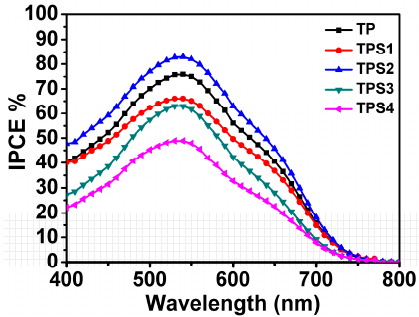
Figure 7. IPCE spectra of DSCs based on TP, TPS1, TPS2, TPS3, and TPS4.